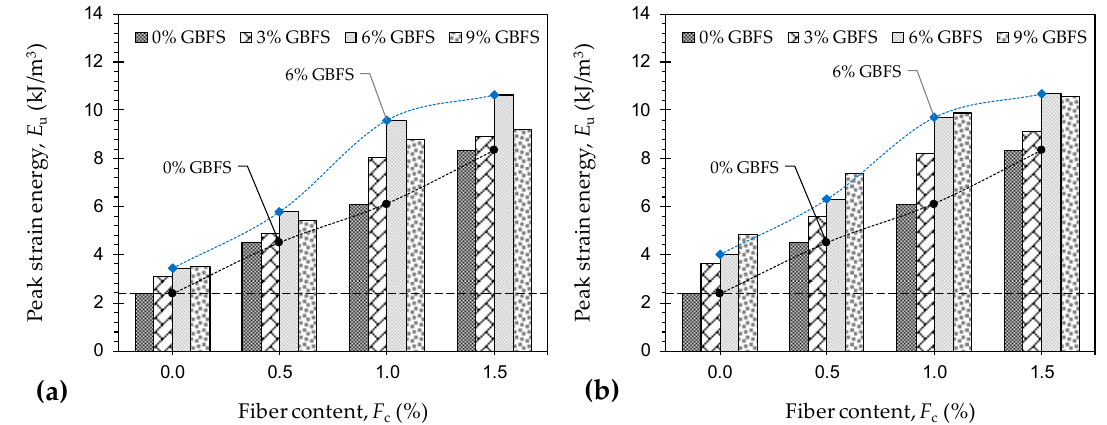
Figure 8. Variations of peak strain energy E u against JF content for the natural soil and various GBFS-treated samples: ( a ) T c = 7 days; and ( b ) T c = 28 days.